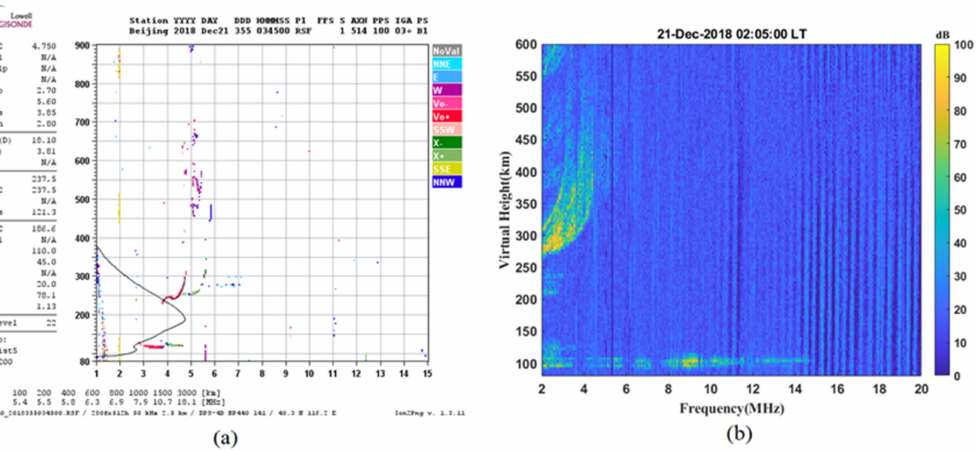
Figure 2. Typical ionograms of the Es layer at Beijing ( a ) and Zhangye ( b ) stations on 21 December